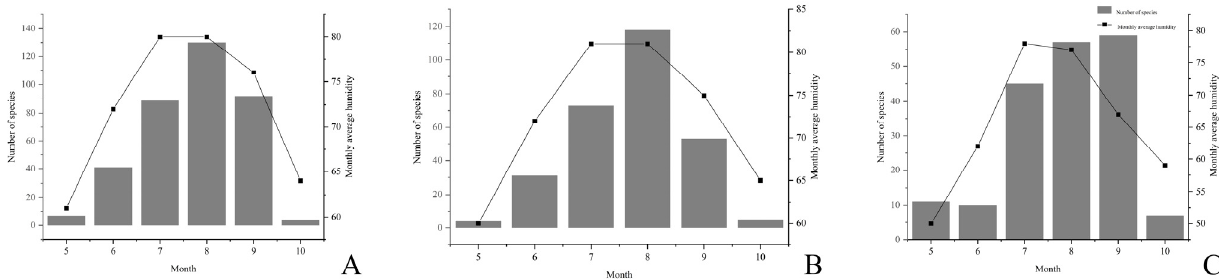
Figure 9. Relationship between macrofungi occurrence and month in three different investigation sites from Jilin Province. The results showed that they mostly arose from July to September. A1: Quanshuidong Forest Farm; B1: Shengli River Forest Farm; C2: Jingyuetan National Forest Park.